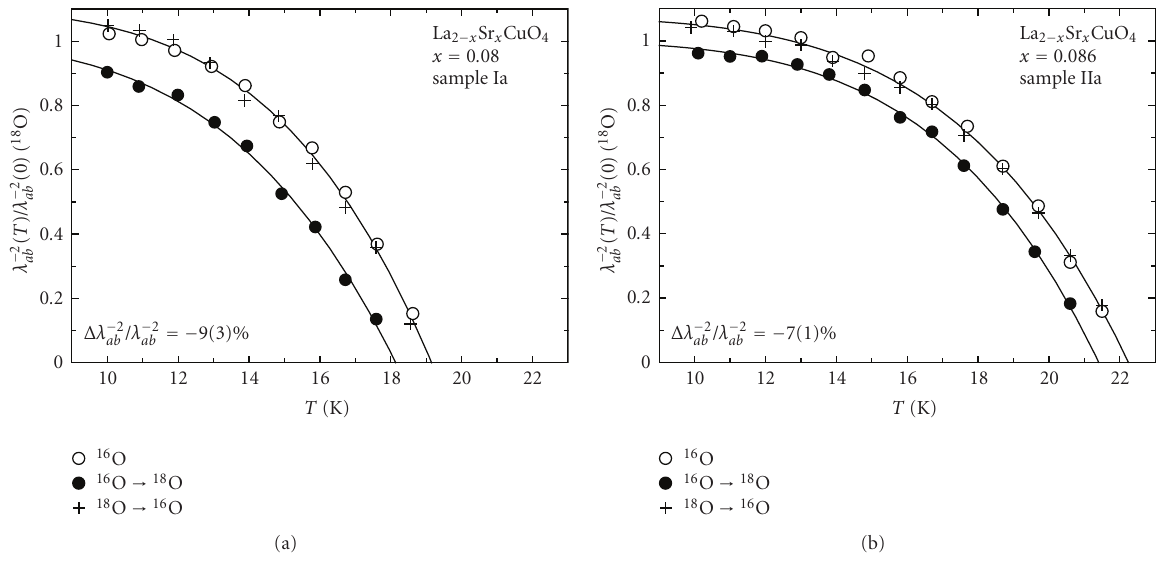
Figure 4: Normalized superfluid density (in-plane penetration depth) λ − 2 La 2 − x Sr x CuO 4 ((a): x = 0.080, (b): x = 0.086). The reproducibility of the oxygen exchange was checked by the back exchange (crosses), after